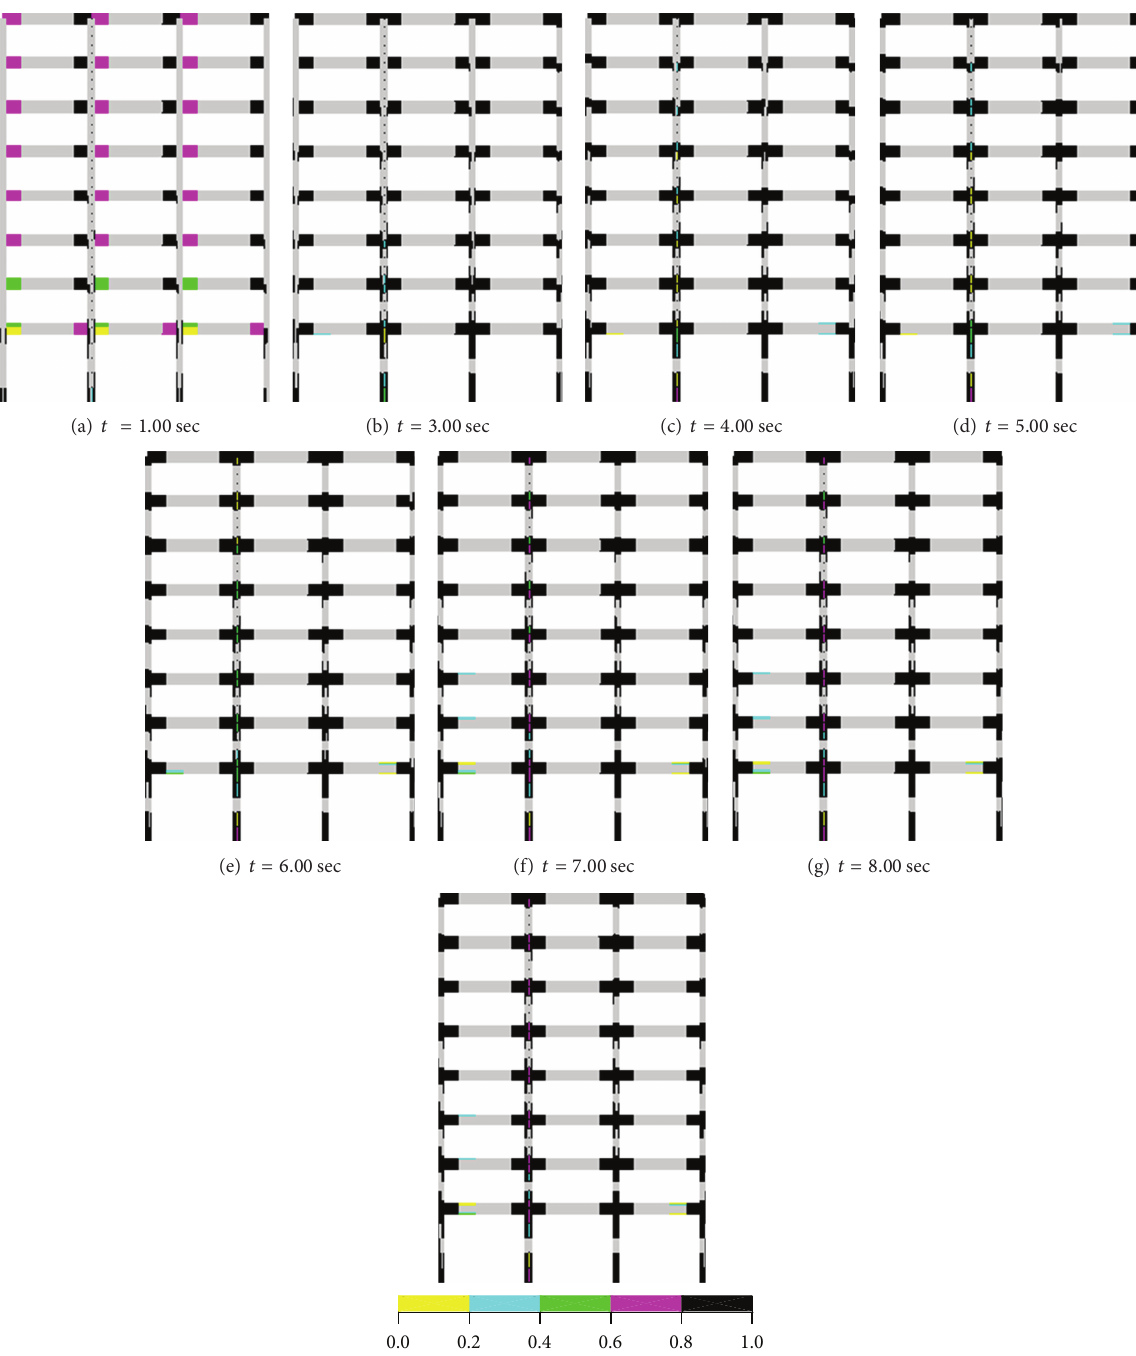
Figure 14: Accumulated damage zones in building for lumped mass/loading